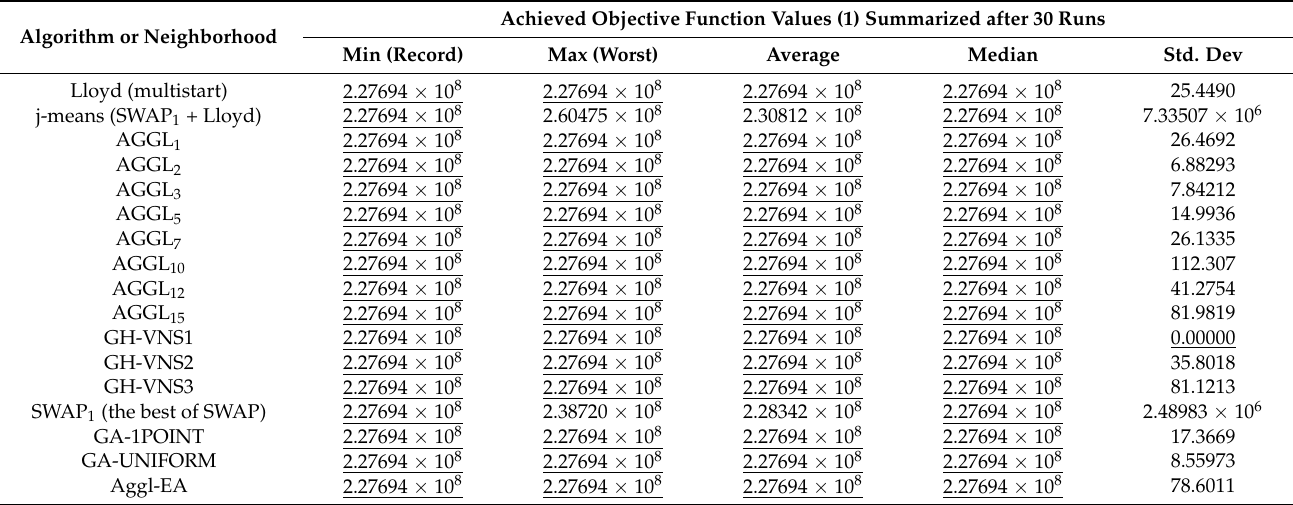
Table A6. Comparative results for S4 dataset. 5000 data vectors in R 2 , p = 15 centers, time limitation 1 s. Algorithm or